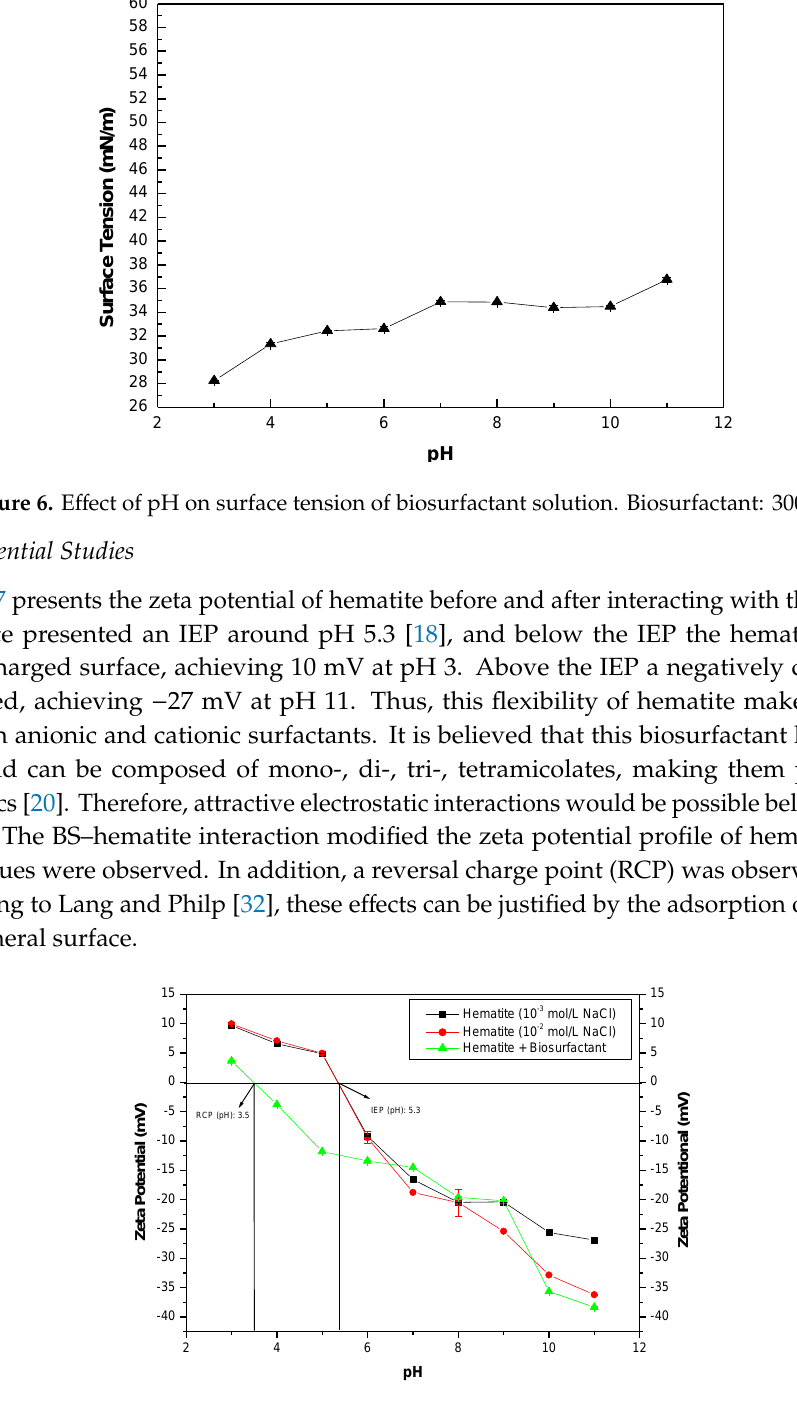
Figure 7. Zeta potential profiles of hematite before and after interacting with biosurfactant (300 mg/L).